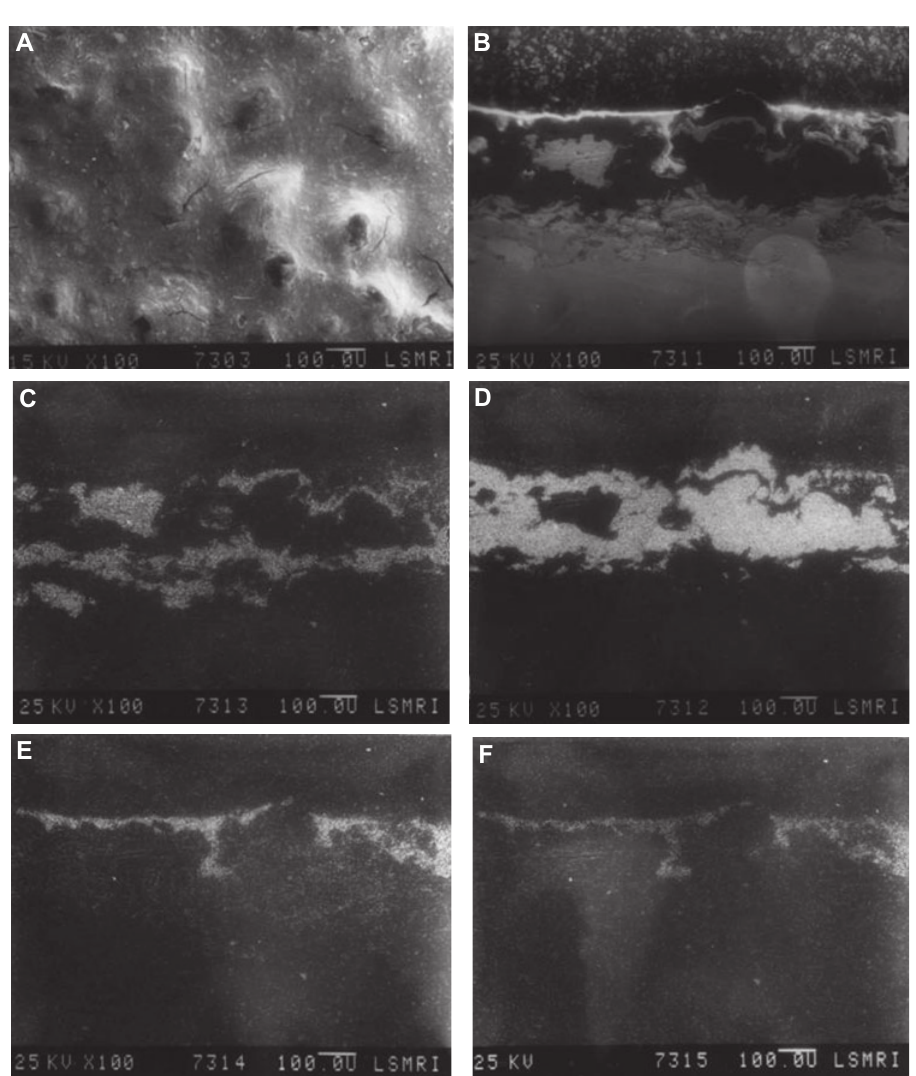
Figure 7 SEM micrographs of sprayed ZAZA coatings after 2 years of experiment: (A) fl at surface (B) section plane of zinc and aluminum coatings, (C) section plane of ZnK α , (D) section plane of AlK α , (E) section plane of ClK α , and (F) section plane of TiK α